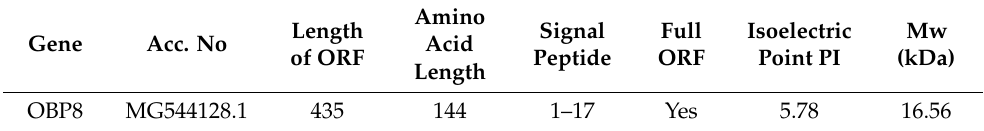
Table 2. List of OBP8 genes in B. odoriphaga